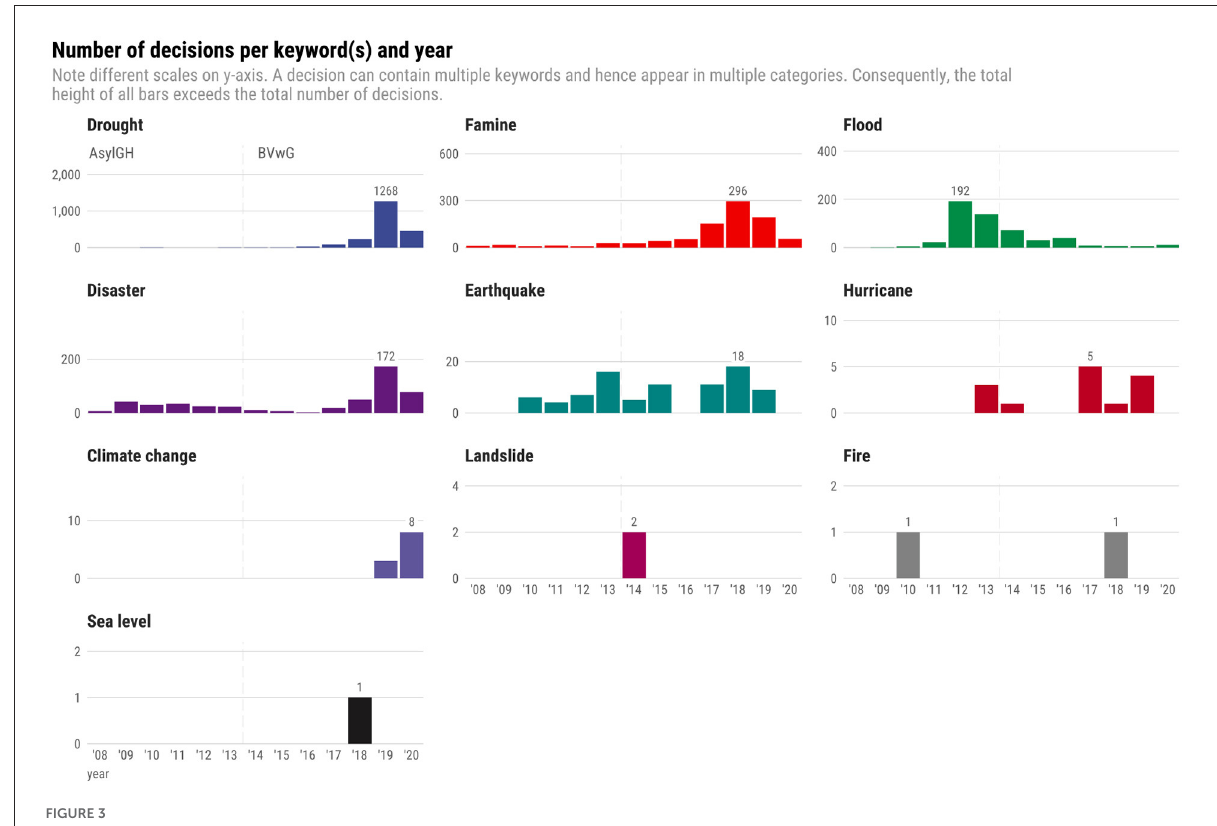
FIGURE3 Number of decisions per